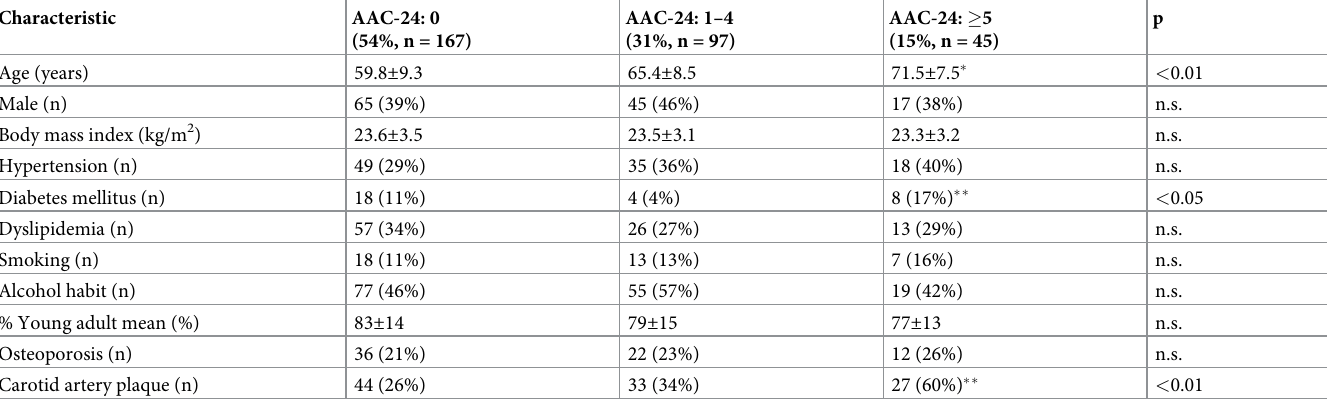
Table 3. Characteristics of the 309 cases by category of AAC-24